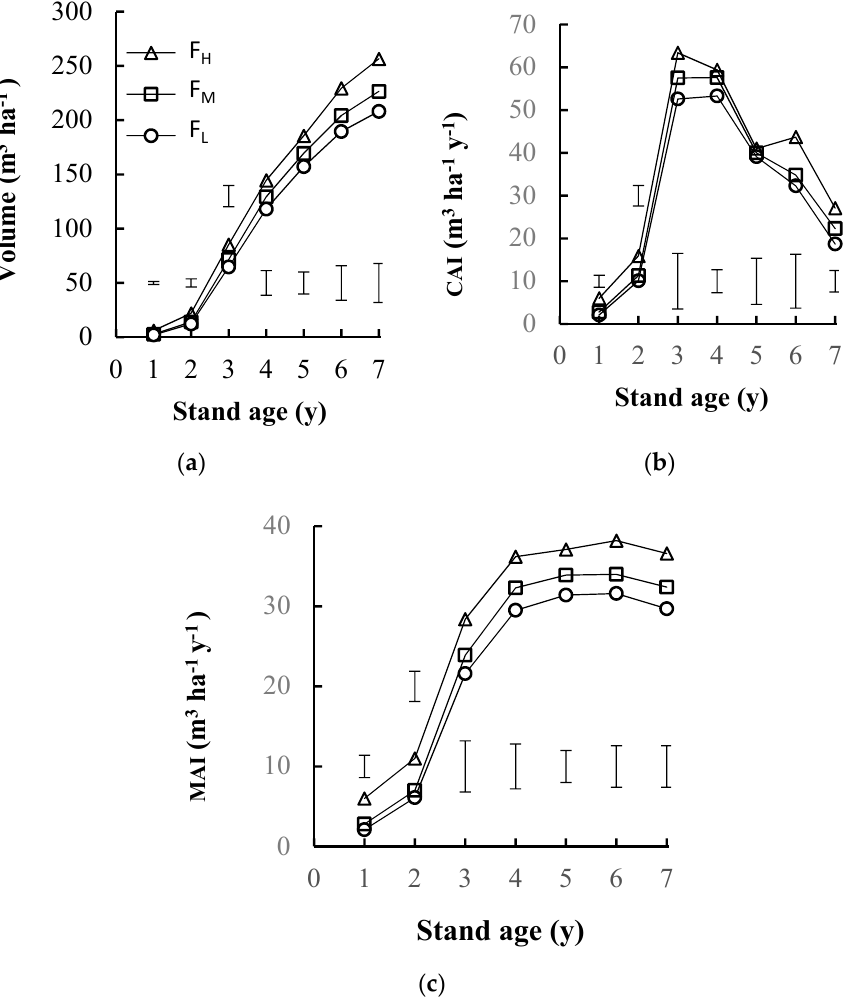
Figure 3. Stand volume ( a ), current annual increments (CAI) ( b ) and mean annual increments (MAI) ( c ) of A. auriculiformis plantation over the seven years in the third rotation and the effects of site management on growth attributes. Vertical bars are LSDs at p < 0.05 .